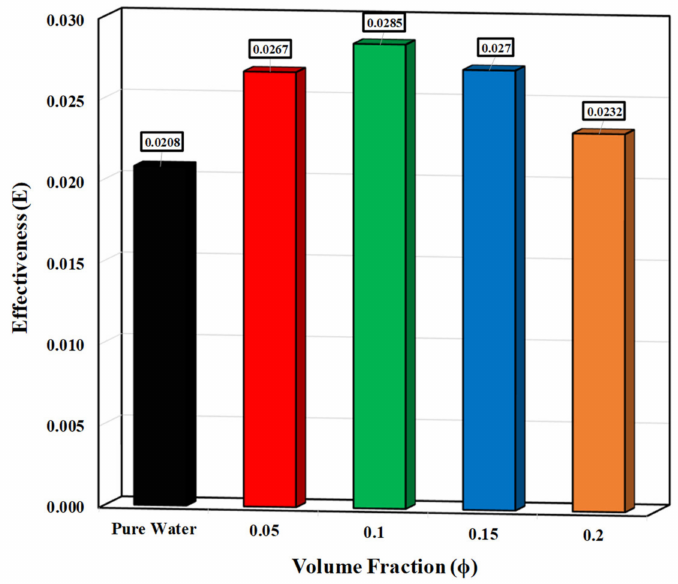
Figure 11. Effectiveness when using Ag-MgO/water hybrid nanofluid with different volume frac- tions at Re =